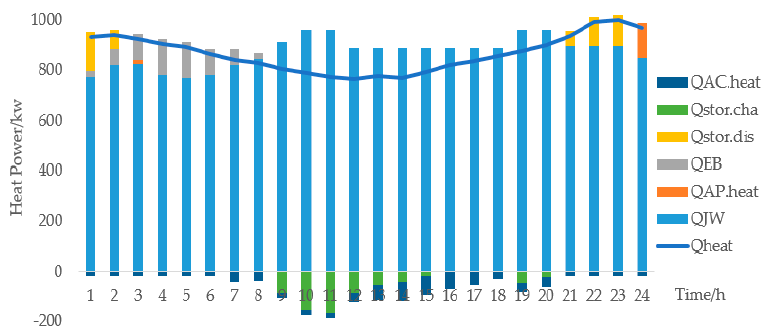
Figure 14. Power output diagram of various equipment before single time scale in summer.